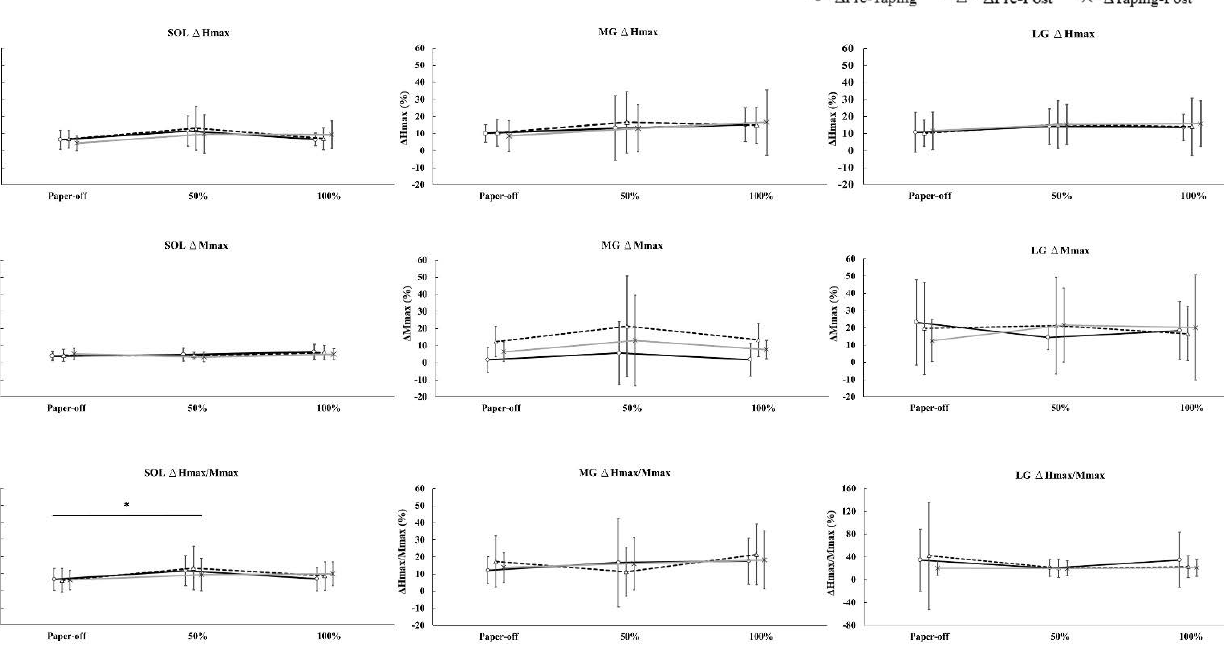
Figure 3. Percentage changes in pre-taping, pre-post, taping-post in paper-off, 50%KT max , and 100%KT max . * Significant difference in pre-post-between paper-off and 50% stretch tension ( p < 0.05).